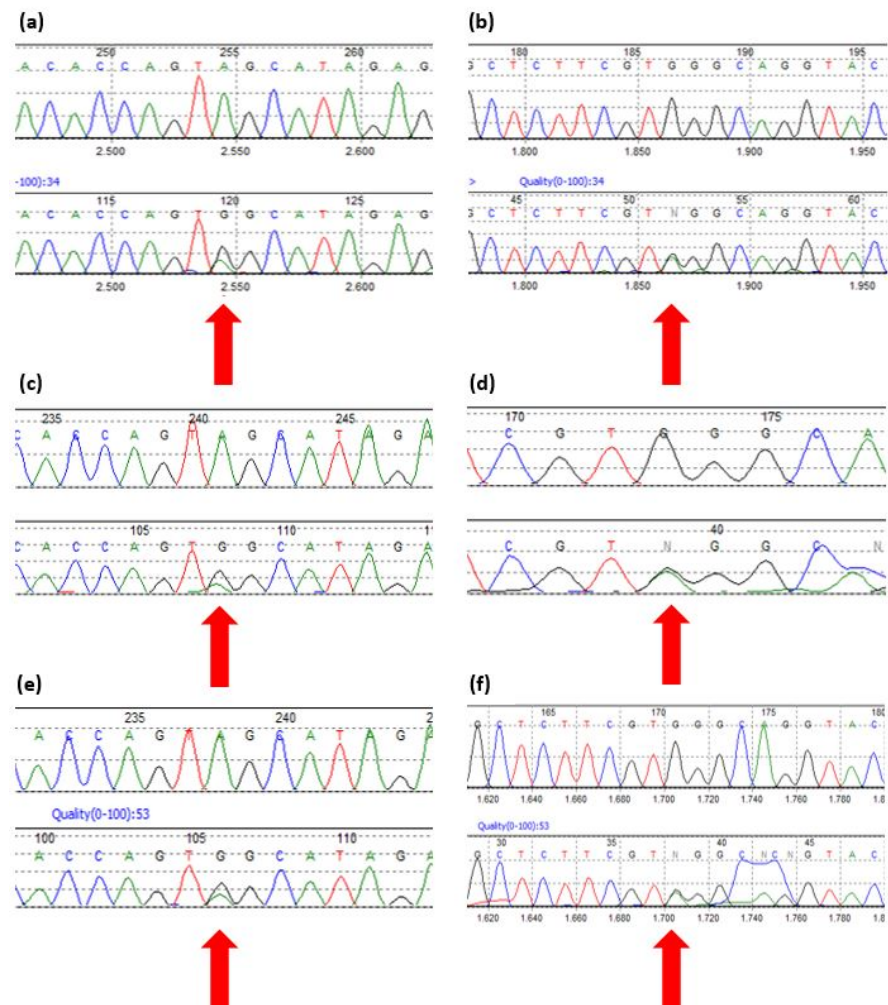
Figure 1. Sequences from Mutation Surveyor v3.30 reporting the mutations found in Patient n.1,